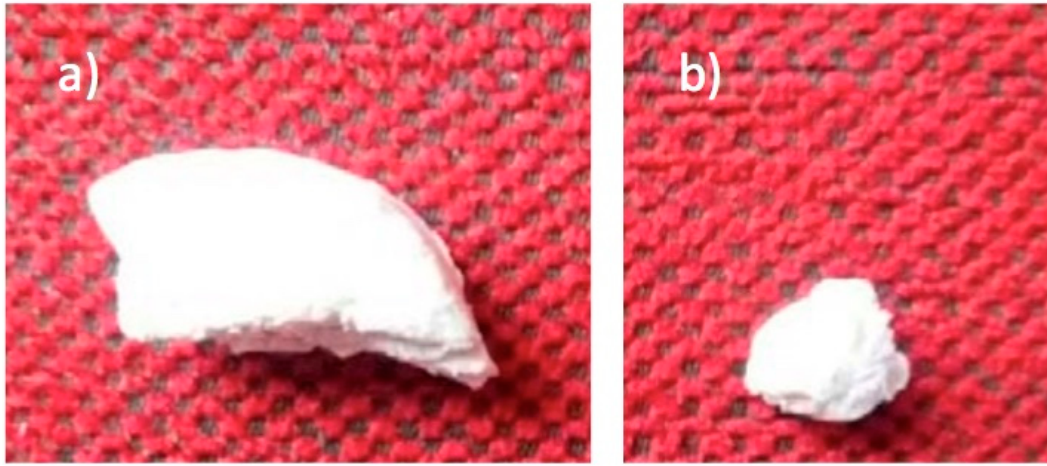
Figure 7. Morphology of PLLA/FeHA 10 wt % ( a ) before and ( b ) after in vitro degradation.